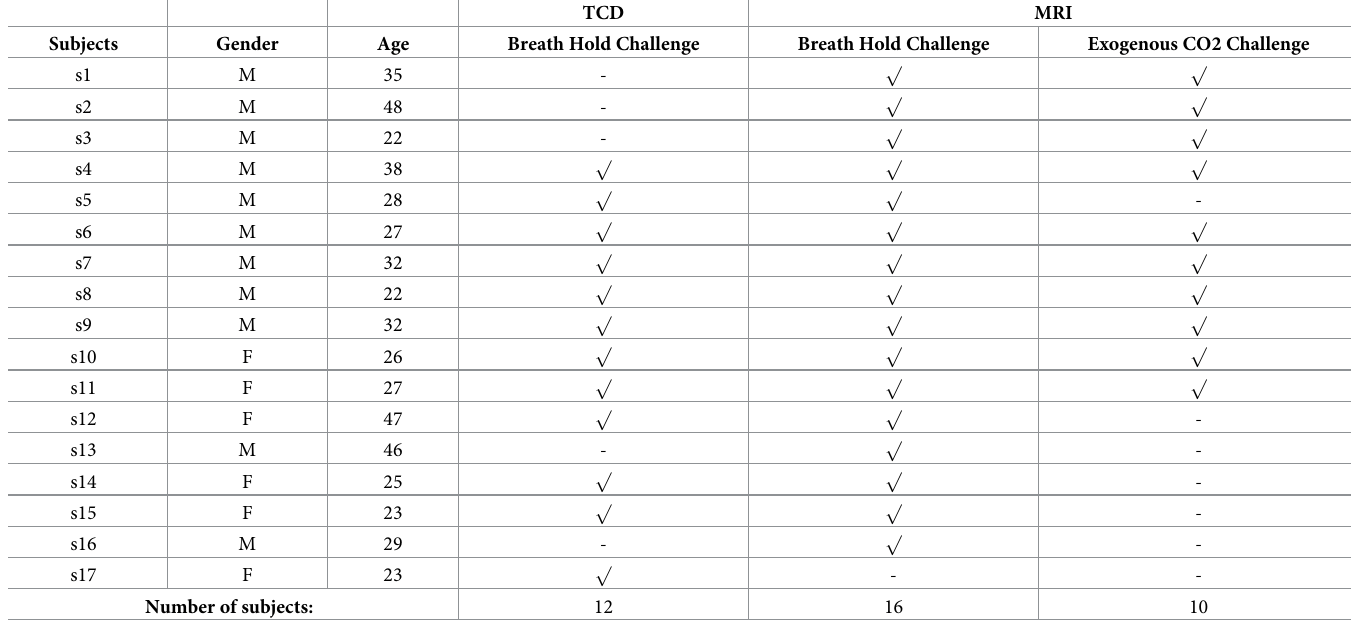
Table 1. Subject demographics and their participation in breath hold and exogenous CO 2 challenges in the TCD and MRI